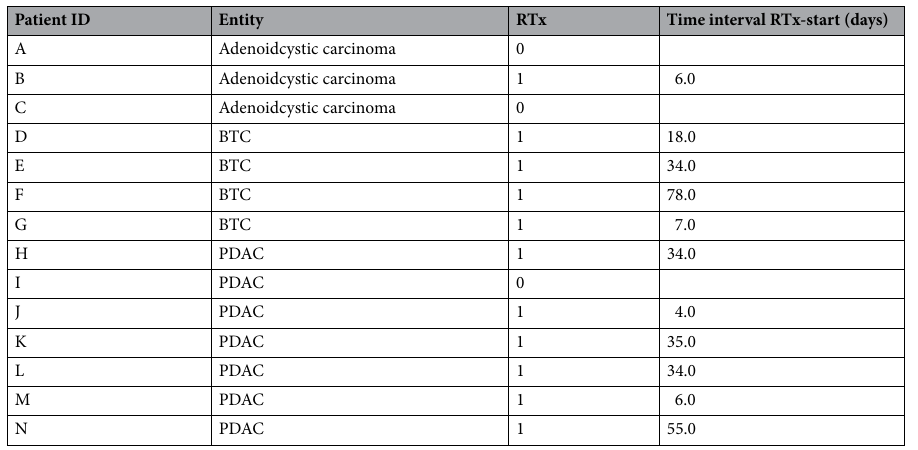
Table 1. Patient characteristics of all consecutive patients with pancreatic ductal adenocarcinomas (PDAC), cholangiocellular/biliary tract (BTC) and adenoidcystic carcinoma (total n = 14) receiving [ 68 Ga]FAPI-PET/ CT for radiation therapy planning (entity; RTx: conducted RTx 1 yes, 0 no; time interval to RTx-start in days; Fx (fractionation dose in Gy); and total dose (in Gy)) [adenoidcystic carcinoma A–C, biliary tract carcinoma D–G, PDAC